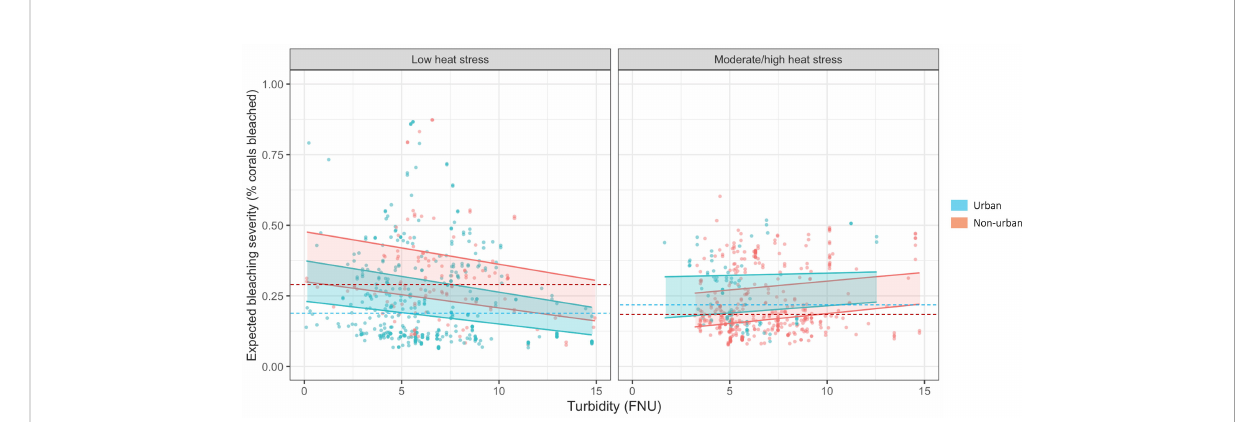
FIGURE 5 Change in bleaching severity with increasing turbidity (unstandardized) under low and high heat stress. Heat stress is divided as low <= 1.15° C SSTa and high >1.15° C SSTa, based on the 50 th percentile of SSTa data. Points represent each observation in the dataset with turbidity mapped against the mean posterior estimate of bleaching severity. Bands represent fi tted 80% credible interval posterior estimates for (blue) urban sites, i.e., U.S. Census-listed urban coastline, and (red) non-urban sites. Dotted lines represent median observed bleaching severity for each category. Note: In low heat stress areas, there are n = 118 non-urban and n = 408 urban sites; in moderate/high heat stress areas, there are n = 405 non- urban and n = 91 urban sites; urban areas and heat stress are not correlated > p = 0.70 (see Supplementary